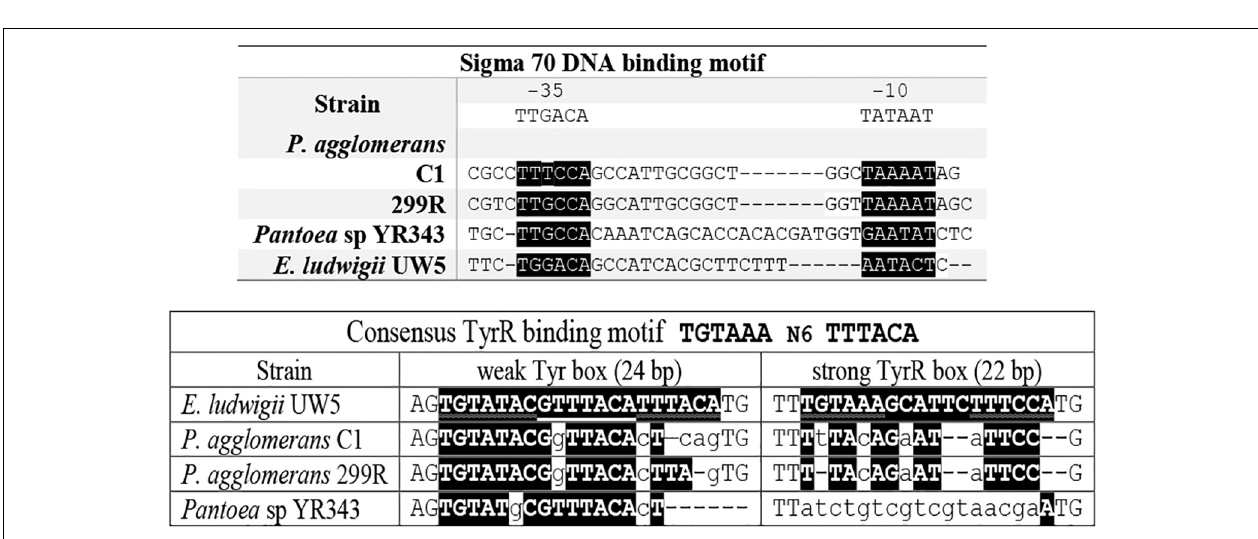
FIGURE 4 | Distribution of sequence identity matches of P. agglomerans strain C1 to other P. agglomerans DNA and protein sequences related to IPyA pathway. The violin plots show the distribution of sequence identities of the ipdC gene cluster (A), the ipdC promoter region (B), the IPDC gene (C g ) and protein (C p ), the amino transferase gene (D g ) and protein (D p ), and the two IAAld dehydrogenase genes (E g and F g ) and proteins (E p and E p ).